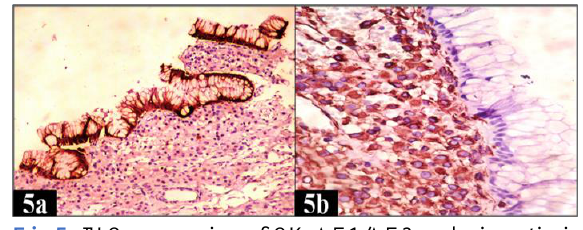
Fig 2. IHC expression of CK AE1/AE3 and vimentin in serous cystadenoma ovary (a) Strong membranous staining of CK (100X)